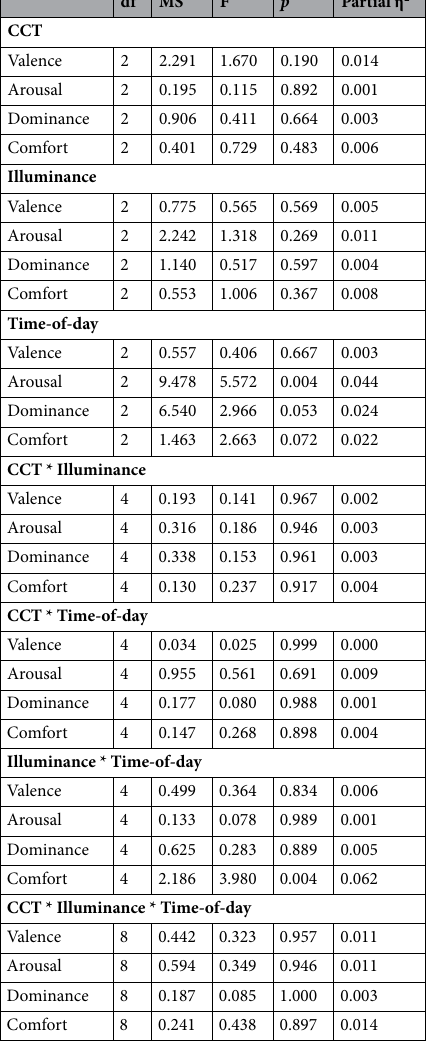
Table 1. MANOVA analysis of CCT, illuminance, and time-of-day on affect and comfort. MS: mean square; F, p , and partial η 2 refer to the F value, significance level, and effect size from the MANOVA analysis, respectively.